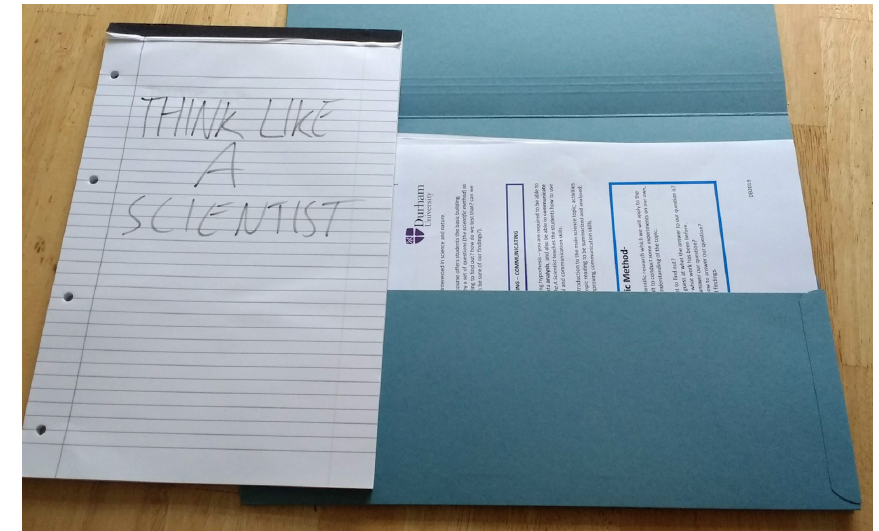
Figure 2. Accessible teaching. By making the equipment requirements for the course as basic as possible, there were no barriers to students accessing education resources. In Think Like A Scientist, only pen and paper were required. Photo credit: Philip J.